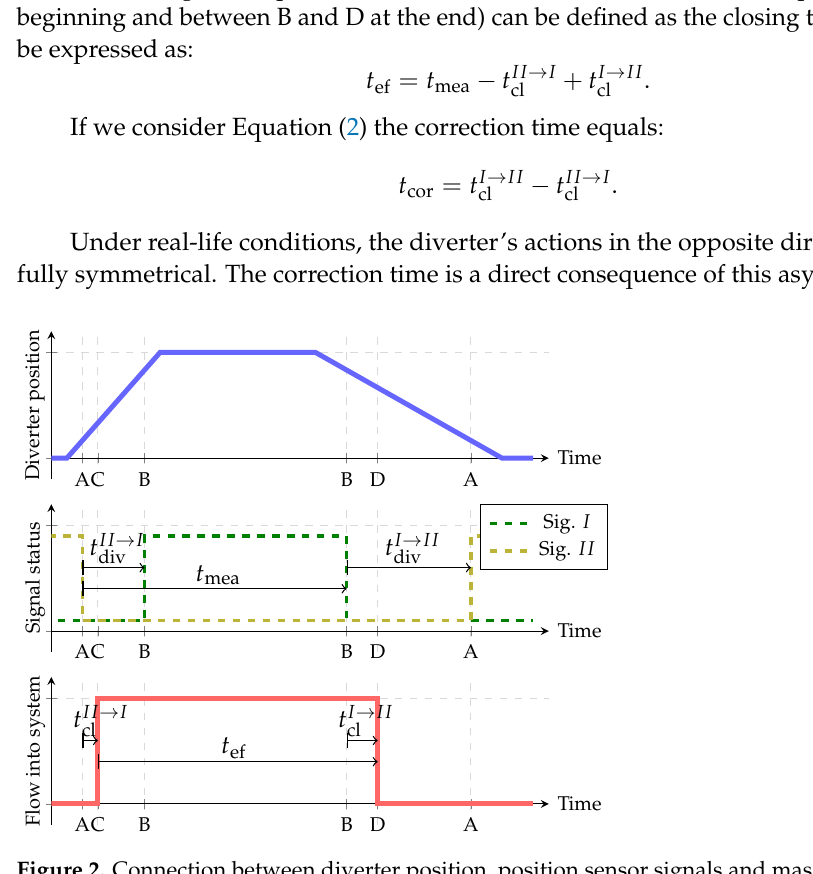
Figure 2. Connection between diverter position, position sensor signals and mass flow into measur- ing